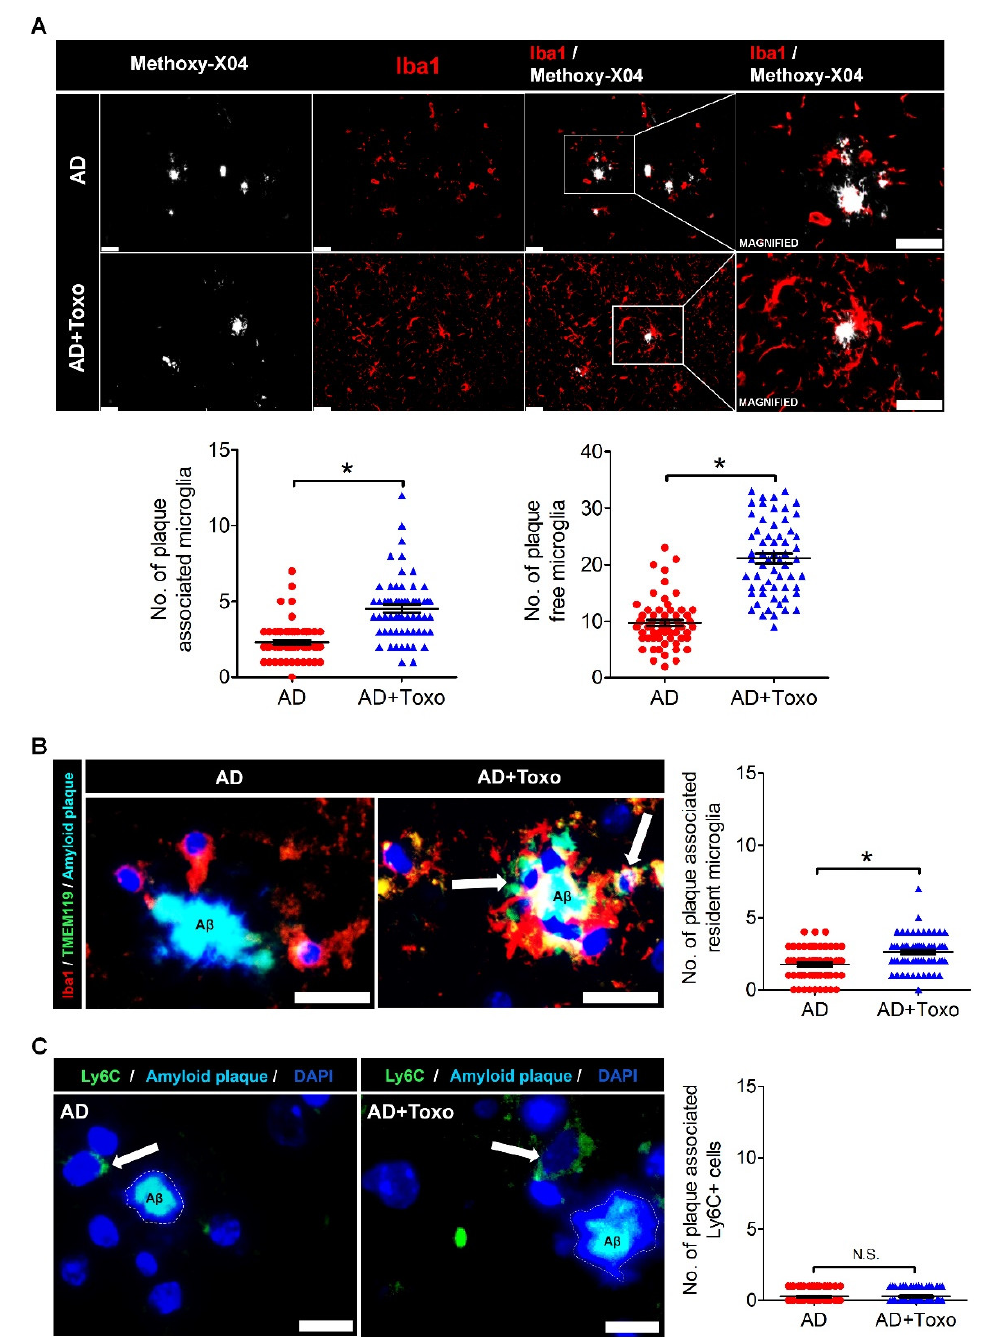
Figure 3. Plaque-associated patterns of microglia and Ly6C + monocytes. ( A ) Iba-1-stained microglia (red) around methoxy- XO4-stained amyloid β (A β ) plaques (white). The counting result of microglia (plaque-associated or plaque-free) found around 60 amyloid plaques distributed in the brain ((10 randomly selected plaques per mouse) × 6 mice per group). Scale bar; 25 µm. ( B ) Plaque-associated homeostatic microglia (yellow, due to co-staining of Iba-1 (red) and TMEM119 (green) and indicated by an arrow). Number of plaque-associated homeostatic microglial cells. Scale bar; 20 µm. ( C ) Ly6C + monocytes (green) accumulated around Aβ plaque in brain tissues of both AD and AD + Toxo groups. (Ly6C + (green) monocytes indicated by white arrow). Number of plaque-associated Ly6C + monocytes. Scale bar; 20 µm. Data are represented as the mean ± SEM. * Statistical significance compared with the control (* p < 0.05).